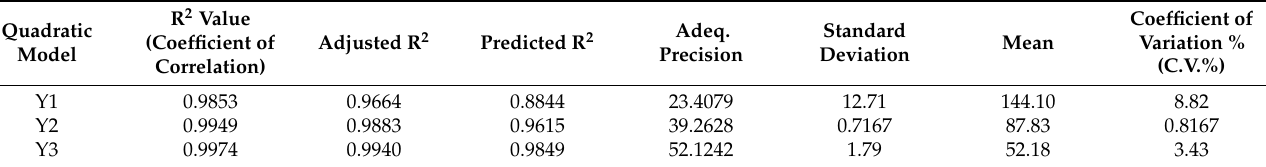
Table 3. Summarized regression analysis data for selected dependent